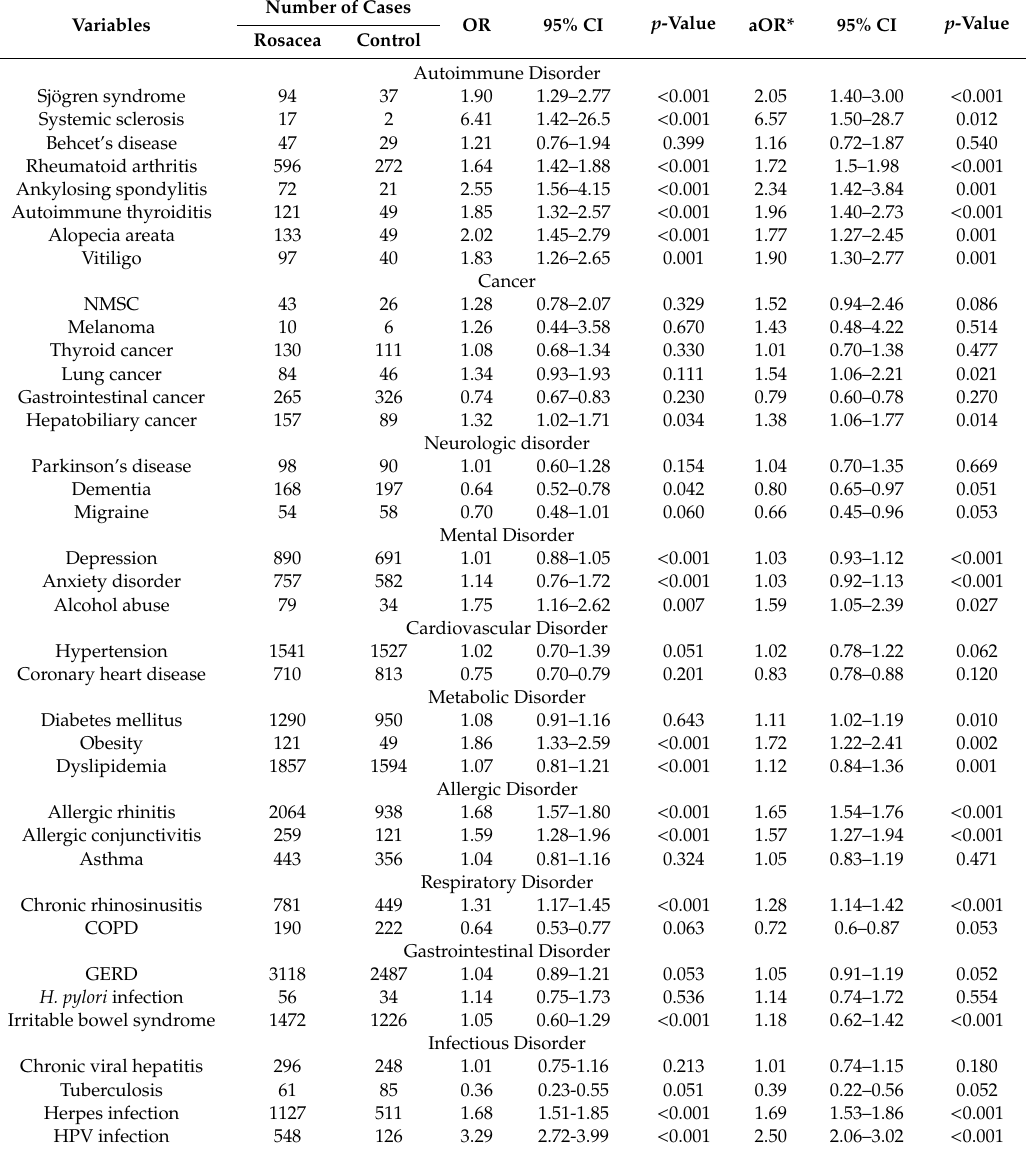
Table 2. Association between rosacea and various systemic